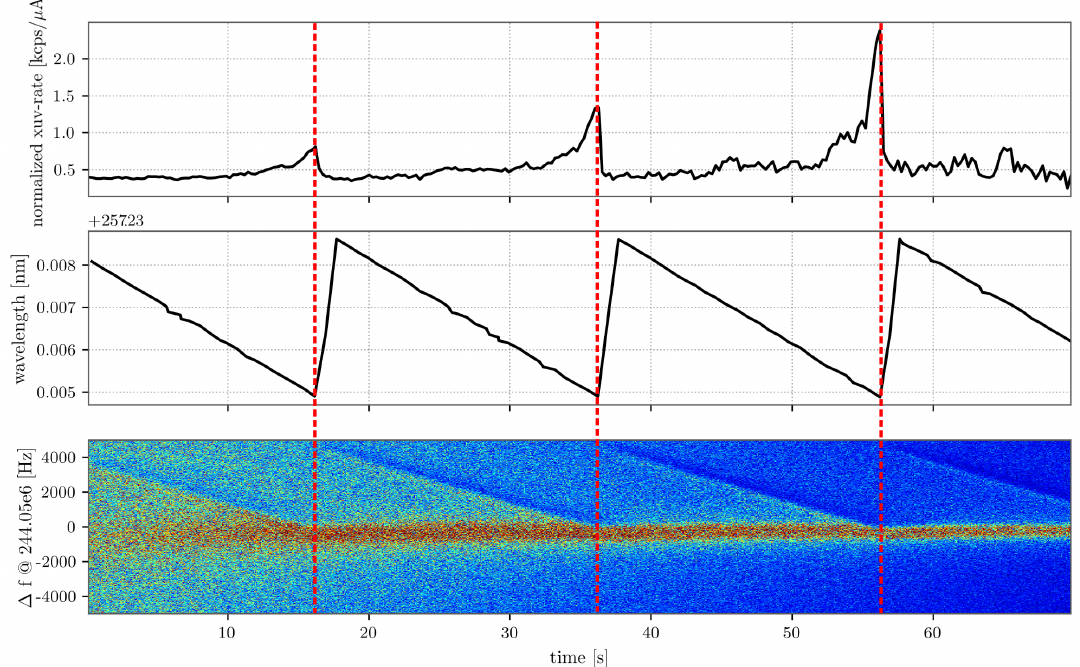
Figure 2. Laser scans of an electron-cooled coasting ion beam of 12 C 3 + ions at the ESR, plotted as a function of time. Top: the rate of the fluorescence photons detected by the XUV detector, middle: the laser wavelength, bottom : the Schottky